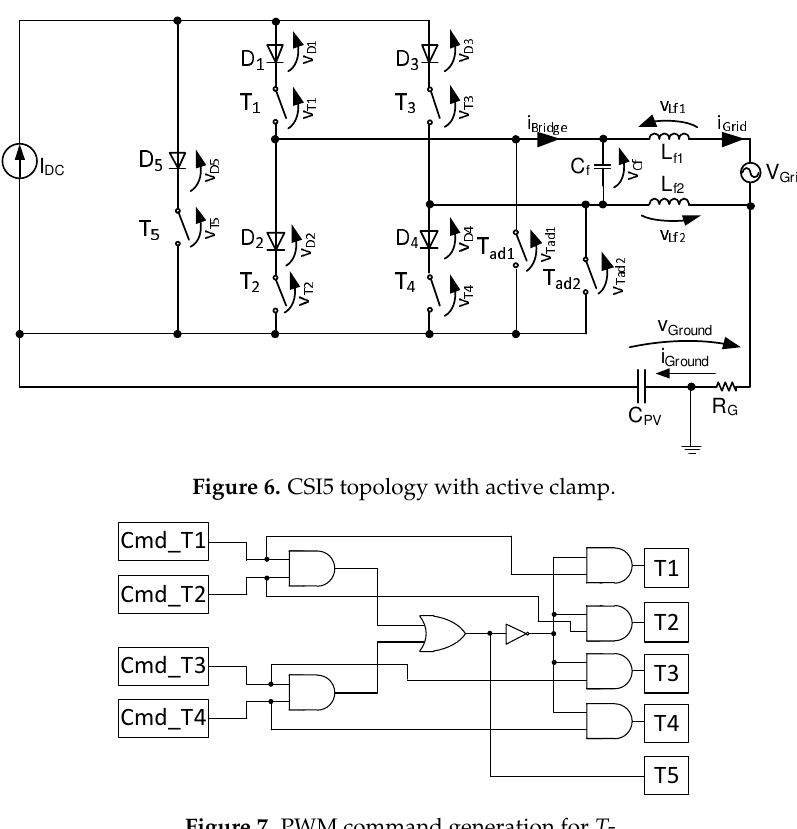
Figure 7. PWM command generation for T 5